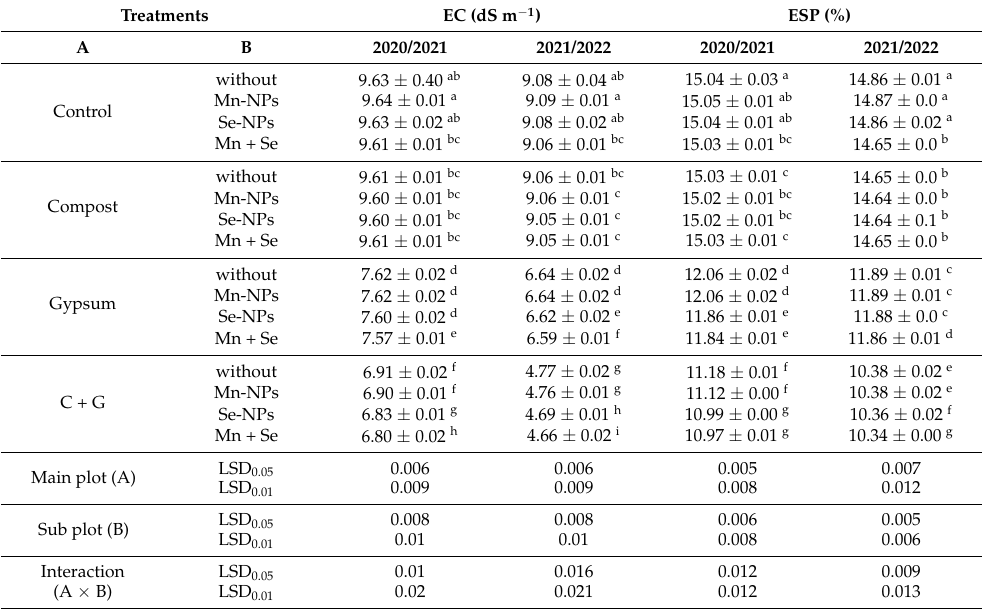
Table 3. Effect of gypsum, compost, and foliar application of some nanomaterials on electrical conduc- tivity (EC e ) and exchangeable sodium percentage (ESP) during the 2020/2021 and 2021/2022 seasons. Treatments EC (dS m − 1 ) ESP